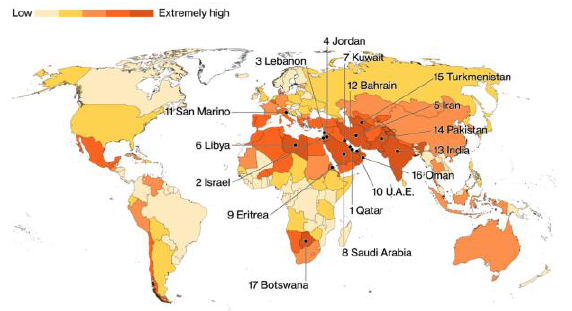
Figure 2 Water stress (Source: World Resources Institute’s Aqueduct Water Risk